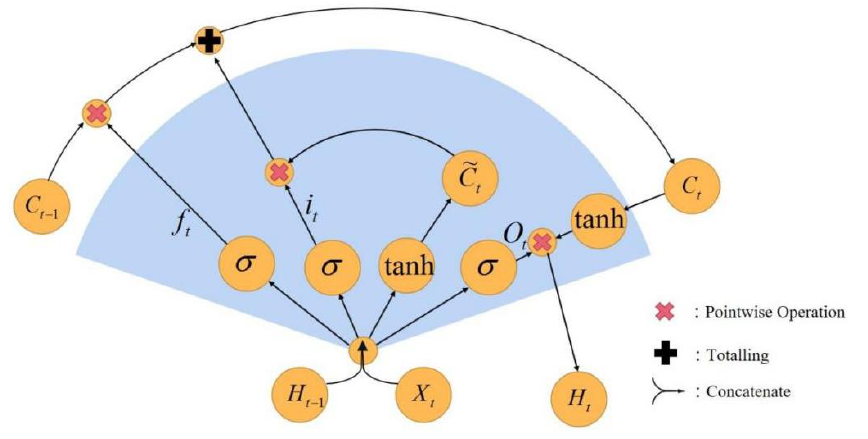
Figure 1. Schematic LSTM network structure.